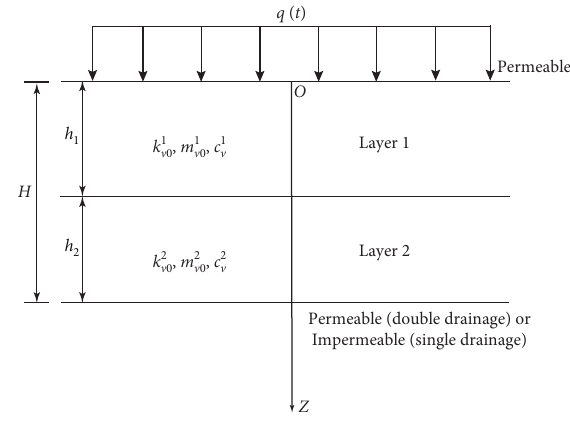
Figure 1: Schematic model of double-layered